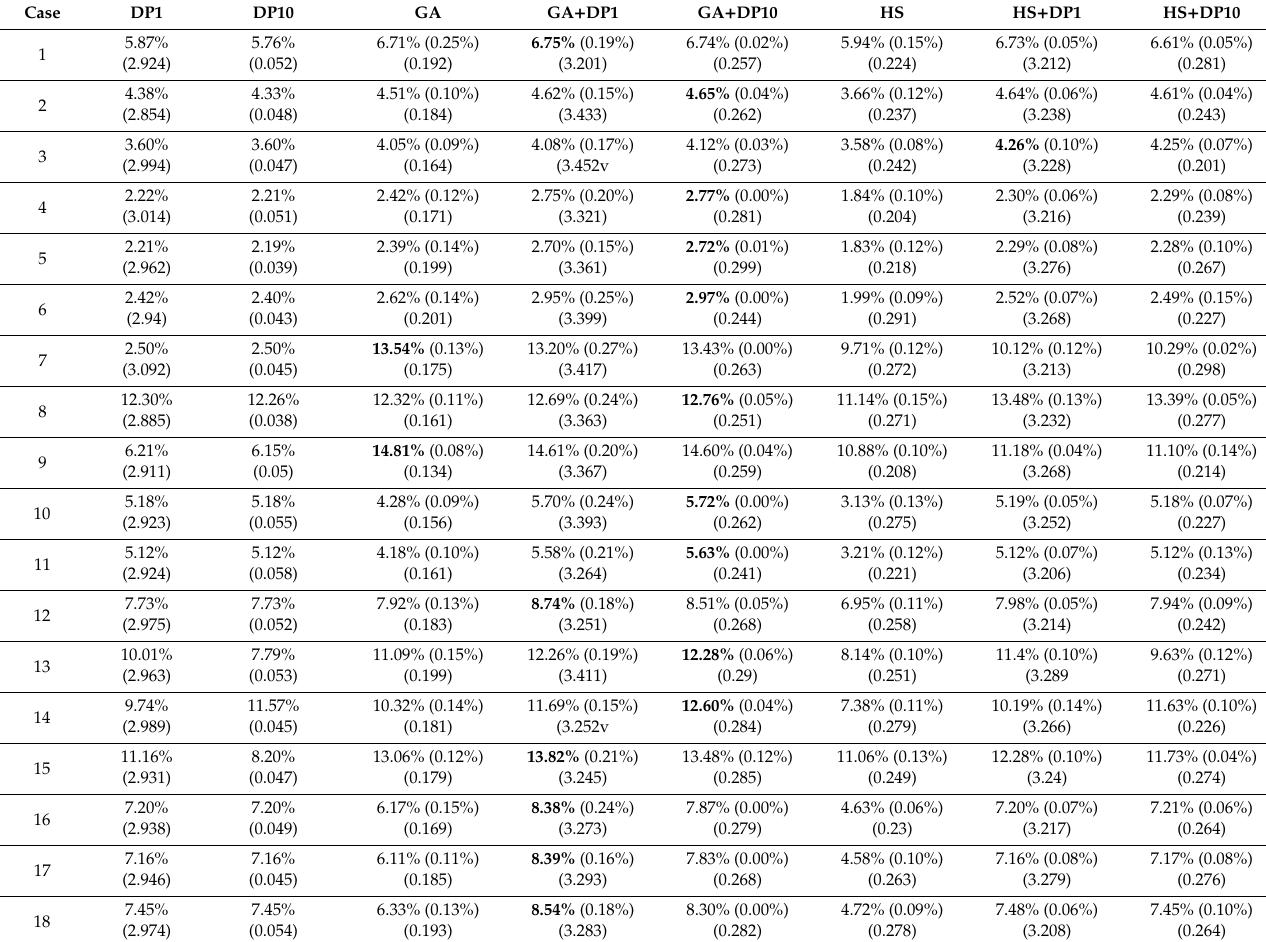
Table 4. Comparison of cost savings of the proposed methods with varying base units including a demand